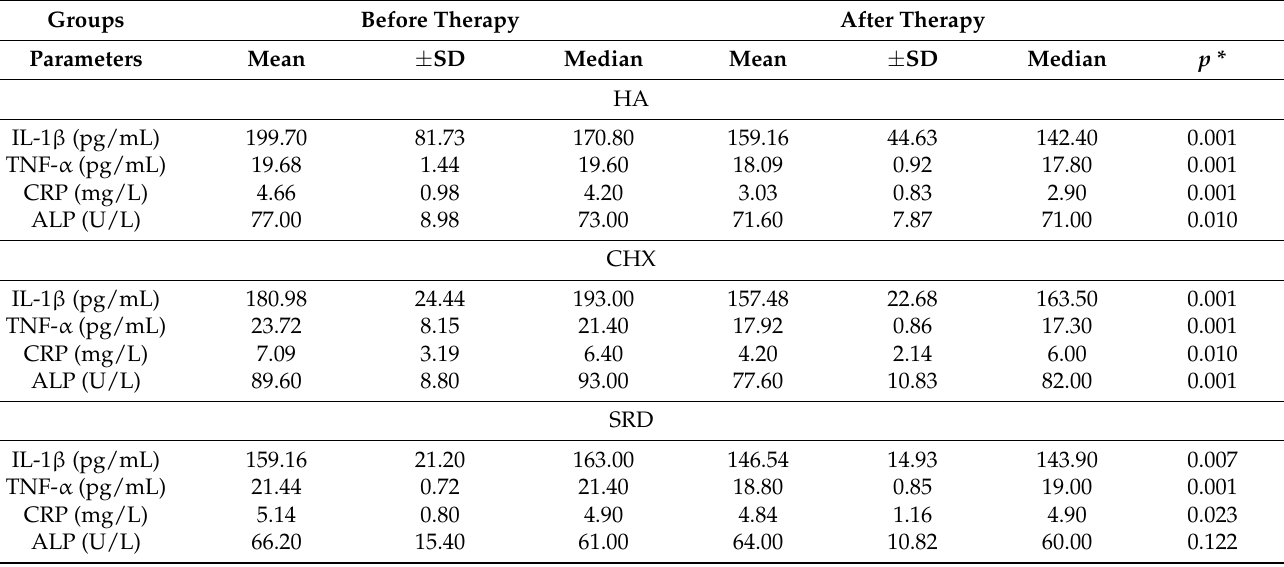
Table 3. Immunological and biochemical parameters before and after therapy for the HA, CHX, and SRD